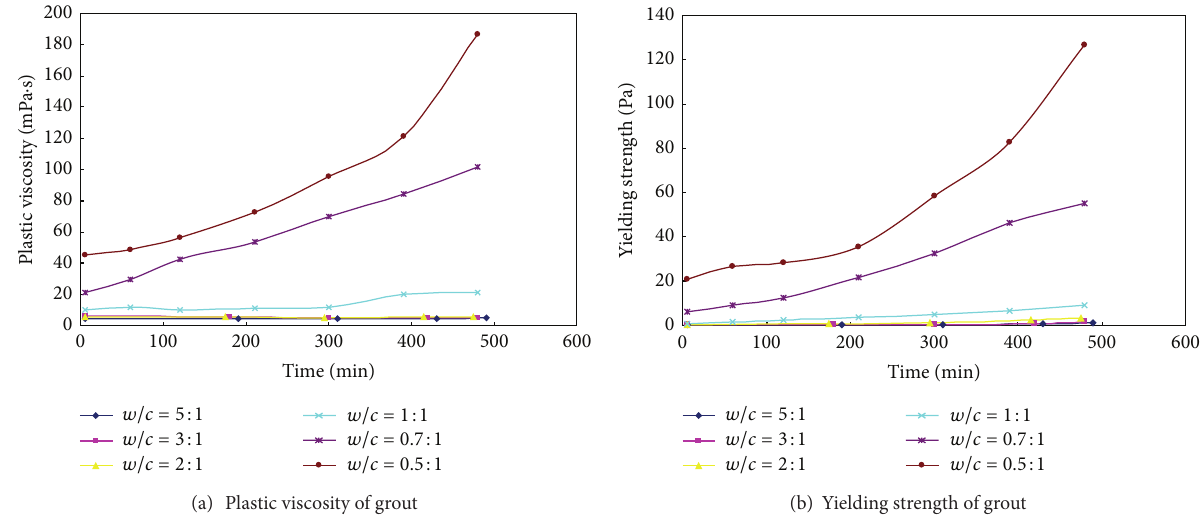
Figure 1: Time variation curves of the rheological parameters for cement grouts at different ratios ( 𝑤/𝑐 is the water-cement ratio of grout).